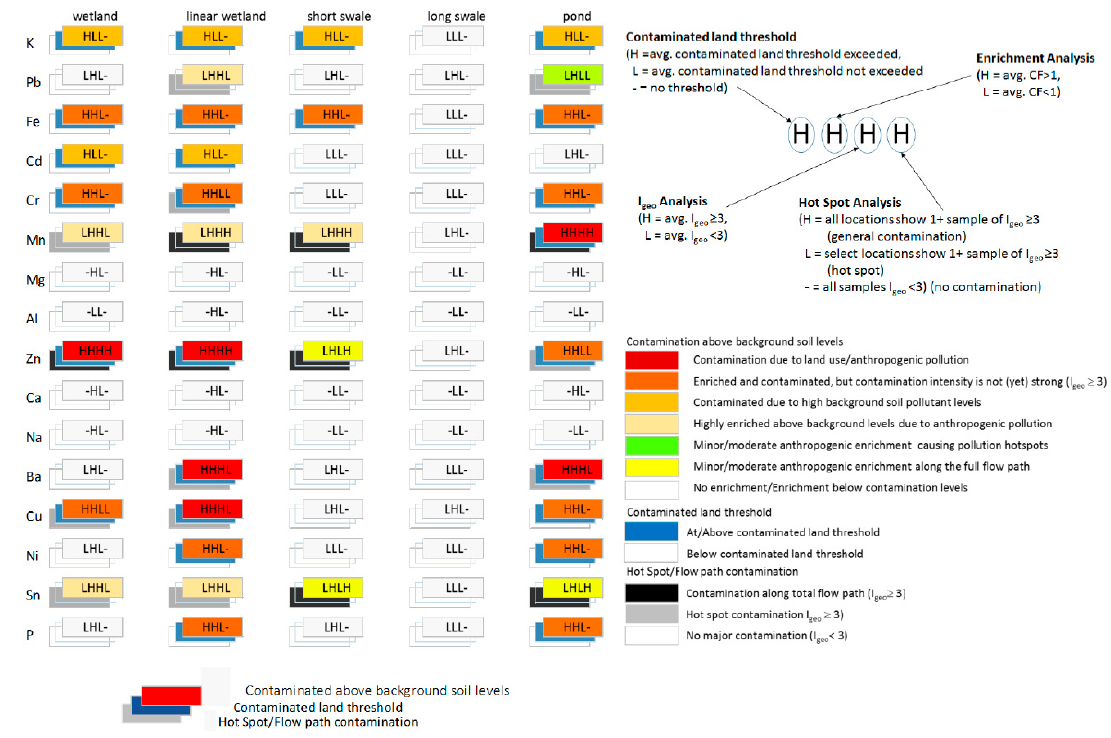
Figure 5. Sediment contamination matrix. The matrix is comprised of three layers of colour indicators, illustrating the alphabetic contamination matrix code (e.g., HHHH, as illustrated to the top right of the matrix).